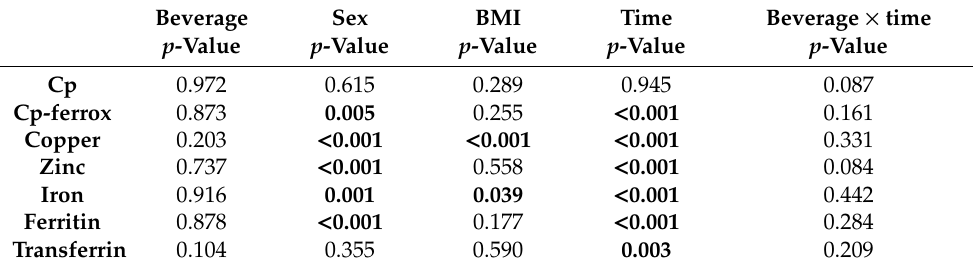
Table 3. p -values for the MIXED procedure repeated measures (time) ANCOVA testing each outcome for the e ff ects of beverage, sex, BMI, time, and beverage × time. Significant values are in bold.